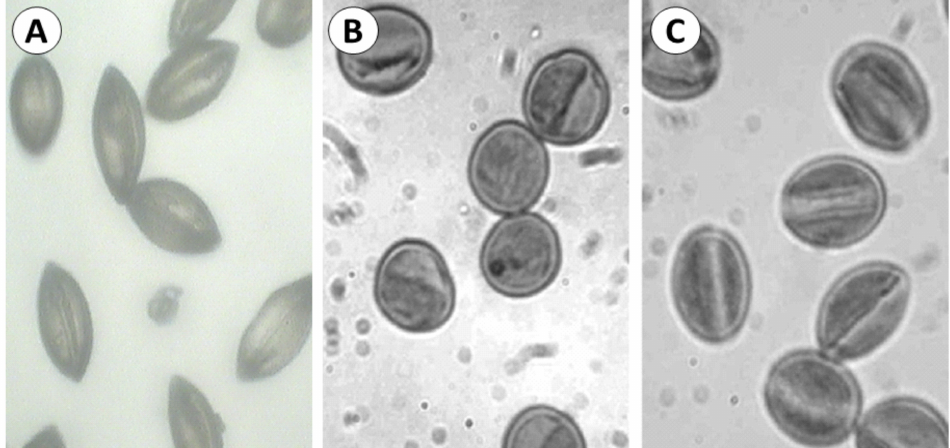
Figure 2. The shapes of pollen grains of the date palm. ( A ) Pollen sourced from date palm seedling male derived from the “Medjool” cultivar, with rhomboid-shaped pollen. The DPP from male trees developed from seeds of the “Deglet Noor”, “Khadrawy”, and “Zahidi” cultivars have also the same shape. ( B ) Pollen sourced from date palm seedling male derived from the “Kacst” cultivar, with spherical-shaped pollen. The DPP from a male tree developed from seed from the “Muzahmiya” cultivar also presented the same shape. ( C ) Pollen source from date palm seedling male derived from the “Heet” cultivar, with elliptical-shaped pollen. The DPP from male trees developed from seeds of the “Dilim” and “Fouzan” cultivars also have the same shape. Source: Image A (Photo by Ricardo Salom ó n-Torres). Images B, C (Adapted from